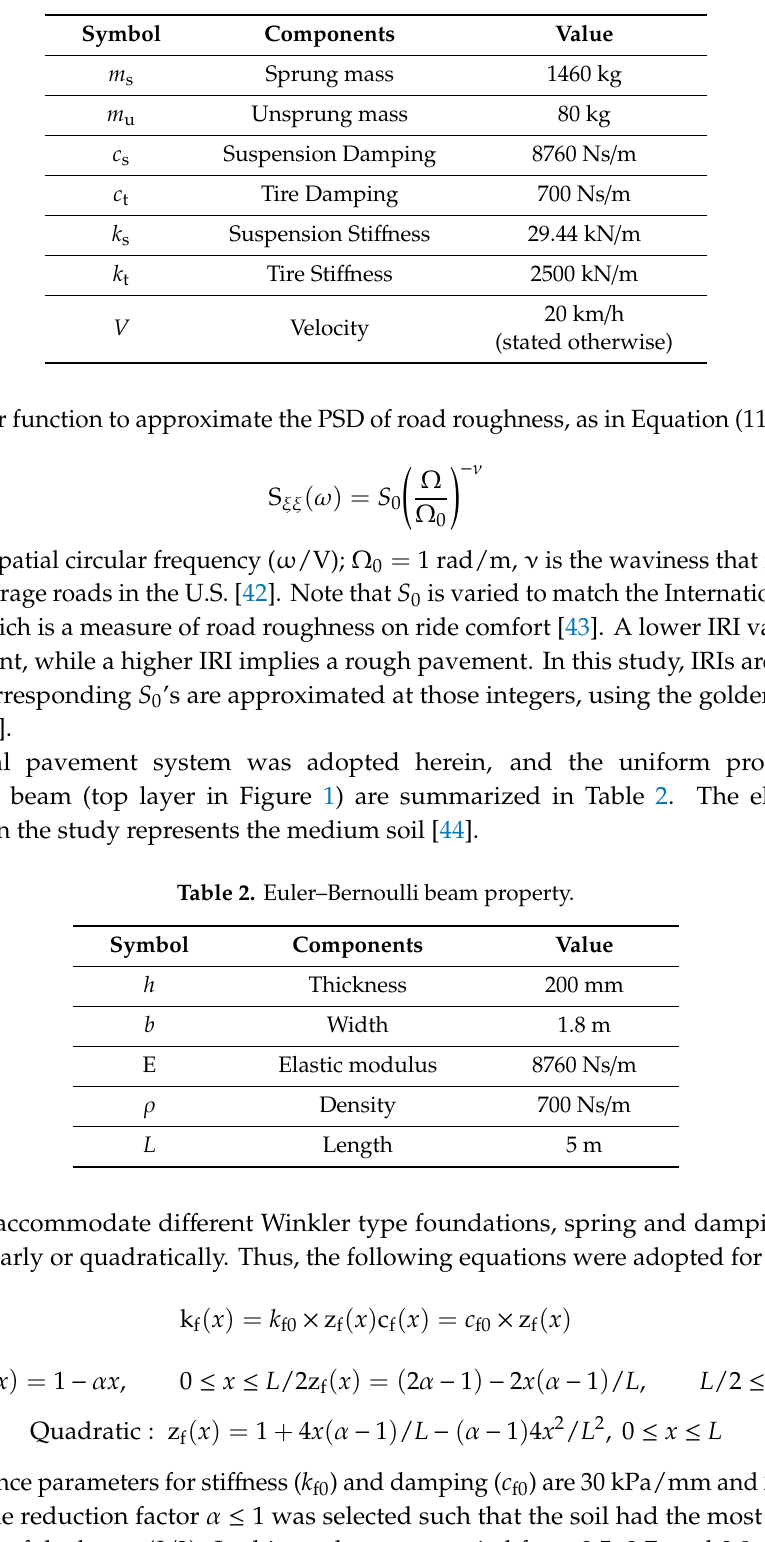
Table 1. Vehicle properties.